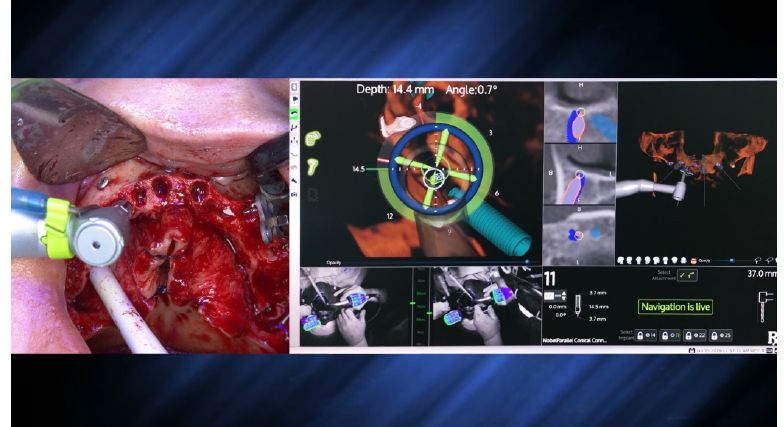
Figure 13. Perioperative and live navigation photograph of the implant insertion. Note the data on the right-hand side demonstrating the precision of implant insertion provided by the system, considering depth (14.4 mm) and angle of the implant (0.7 degrees), towards the target of insertion retrieved by the system.